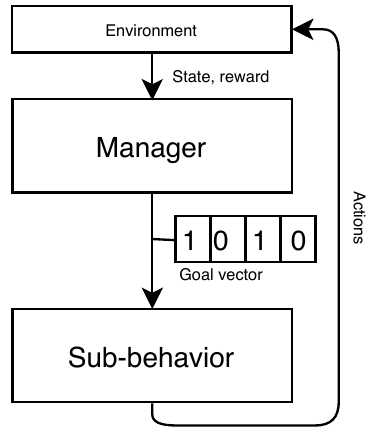
Figure 8. Goal-conditional